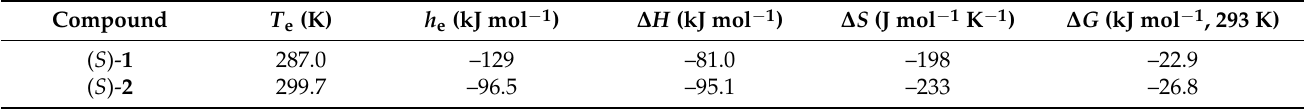
Table 1. Thermodynamic Parameters Obtained by Fitting Temperature-Dependent UV-Vis data. a